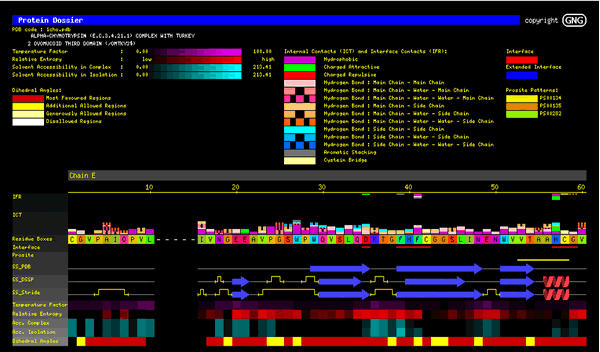
SMS Protein Dossier. Protein Dossier module – The meaning of the colors are on the top part of the image. The internal and interface forming contacts are shown above the amino acid sequence cartoon, color coded according to the type of contact. The first row (red line) under the sequence highlights the residues at the interface. The next row (yellow line bellow the sequence stretch: VTAAHGC) indicates the PROSITE pattern PS00134. The following three rows indicate the secondary structure according to the annotations in PDB, DSSP and Stride, respectively. Another five rows are displayed color coded according to: temperature factor, relative entropy, accessibility in complex, accessibility in isolation and dihedral angles.